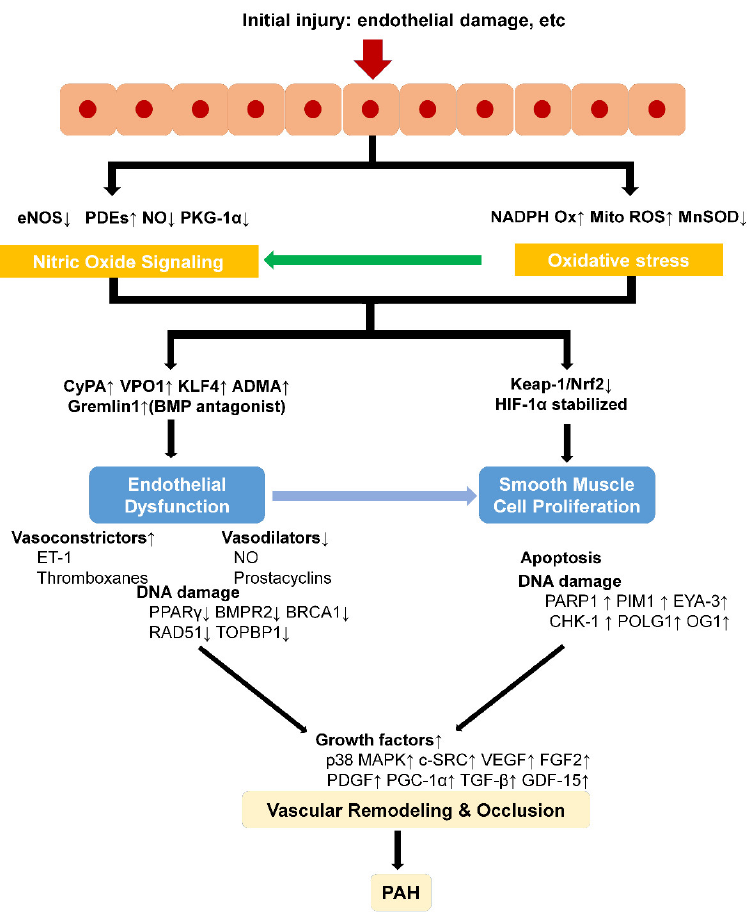
Figure 3. Schematic mechanisms of oxidative stress in PAH. Abbreviations: PDE, phosphodiesterase-5, PKG-Iα, protein kinase G-Iα, CyPA, cyclophilin A, VPO1, vascular peroxidase1, KLF4, Kruppel-like factor 4, ADMA, asymmetric dimethyl arginine, BMP, bone morphogenic protein, BRCA1, breast and ovarian cancer susceptibility protein 1, TOPBP1, topoisomerase DNA II-binding protein 1, PARP1, poly (ADP-ribose) polymerase 1, PIM1, provirus integration site, EYA-3, eyes absent homolog-3, CHK-1, checkpoint kinase 1, POLG1, mitochondrial DNA polymerase γ, OG1, 8- oxoguanine glycosylase, FGF2, fibroblast growth factor 2, PDGF, platelet-derived growth factor, PGC-1 α , peroxisome proliferators-activated receptor- γ -coactivator-1, GDF-15, growth differentiation